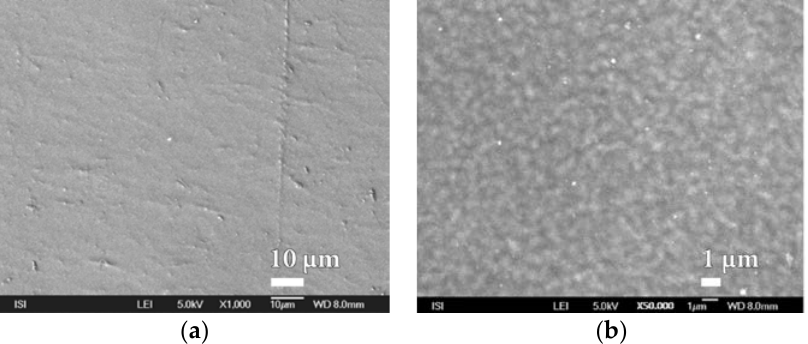
Figure 6. Scanning electron microscopy (SEM) micrographs of the surface of the nanolayer of SiO x prepared by HMDSO method on the silicon substrate at various magnifications before exposure to DCH ( a ) 1000× and ( b ) 50,000×.